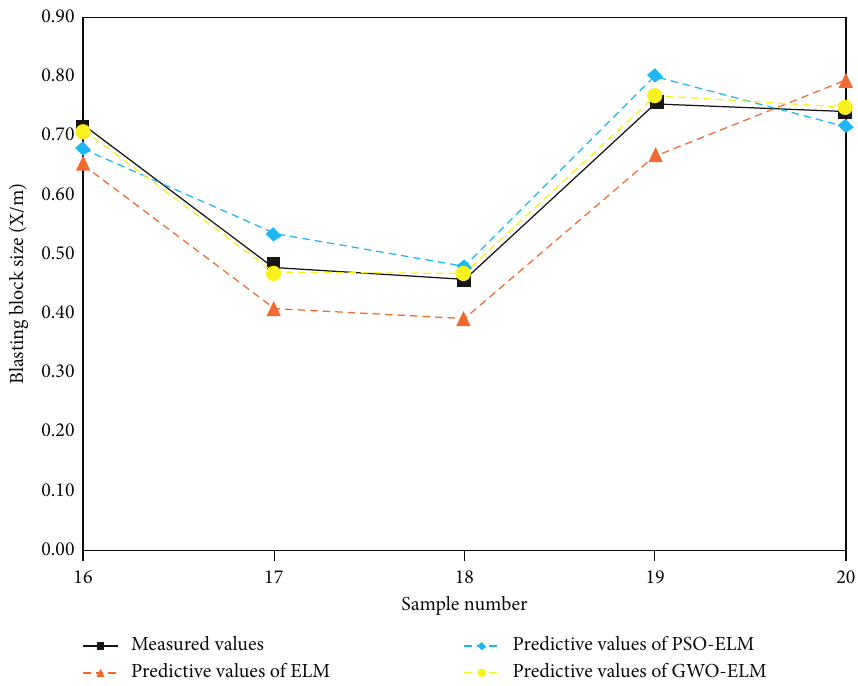
Figure 5: Comparison of model predicted value and measured value. Table 2: Model comparison of predictive values and measured values of average size of blasting block X